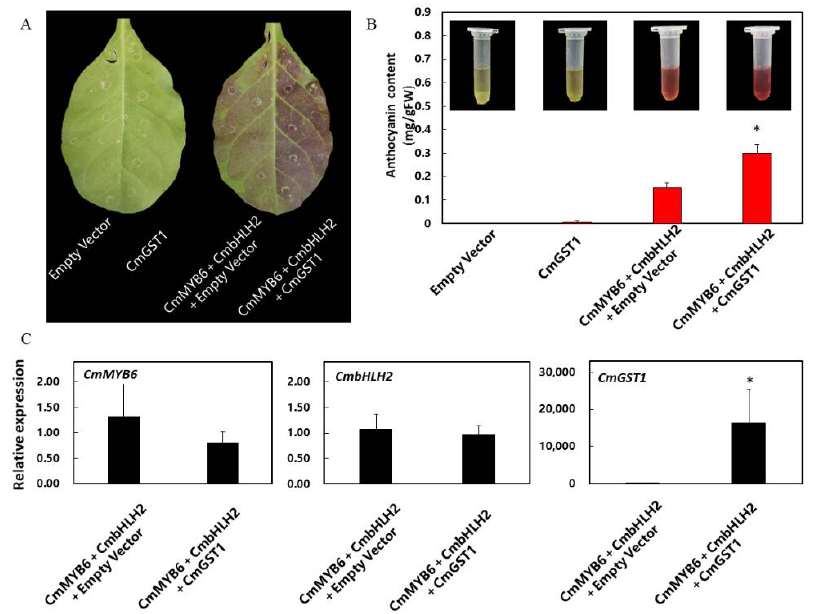
Figure 5. Transient overexpression of 35S::CmMYB6-bHLH2 together with 35S::CmGST1 in tobacco ( Nicotiana tabacum ) leaves. ( A ) A photograph of tobacco was taken at 7 days after injecting. ( B ) Anthocyanin content of tobacco leaves. ( C ) Transcriptional factors’ relative expressions of transient overexpression of 35S::CmMYB6-bHLH2 and empty vector or 35S::CmGST1 in tobacco ( Nicotiana tabacum ) leaves. Data were means (±SE) from three independent biological replicates. Asterisks indicate significant differences (* P < 0.05).